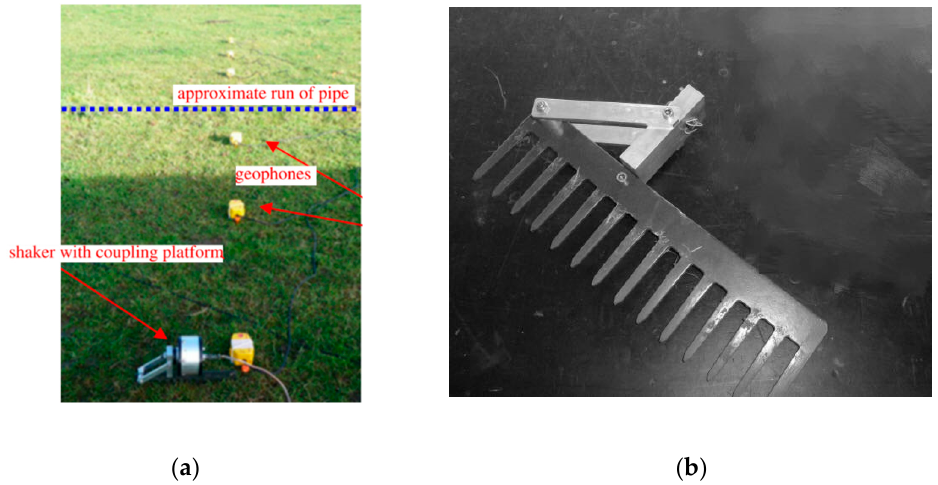
Figure 14. ( a ) Experimental set-up for shear wave method [102] Copyright Elsevier, 2014; ( b ) specially designed platform used to couple the shaker to ground [100].